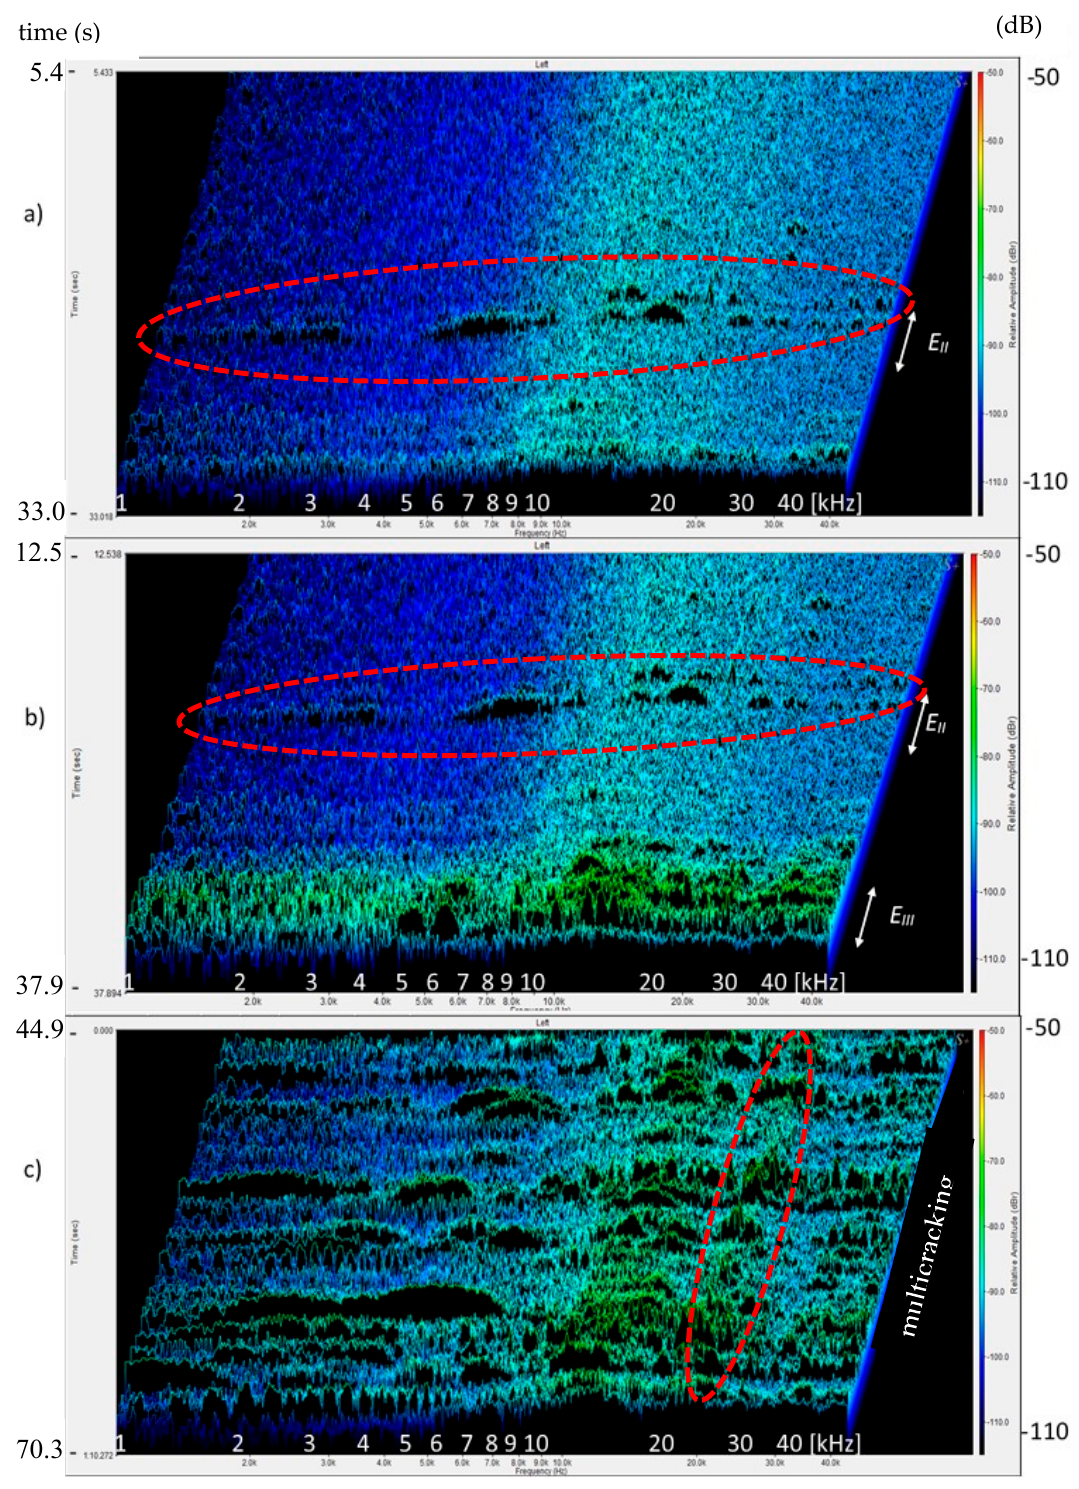
Figure 7. Composite sound spectra: ( a ) background, micro-events E II , ( b ) micro-events E II and E III , ( c ) multicracking between points f 1 and f 2 . Figure 8a is an image of the sound spectra of the composite: its background, events E II , E III , and the critical point f cr . Figure 8b presents the spectra of the area of sudden drops in stress in points f 1 and f 2 in the time range 74.8–102.3 s. Figure 8c shows the spectra of event in point f tb and spectra of